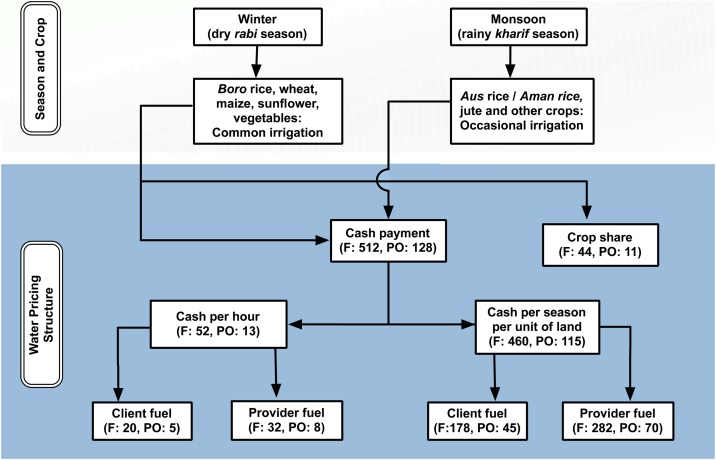
Different types of irrigation service institutions in Bangladesh (numbers indicate the number of observations in each group). F: Client-farmer, PO: Pump owner.